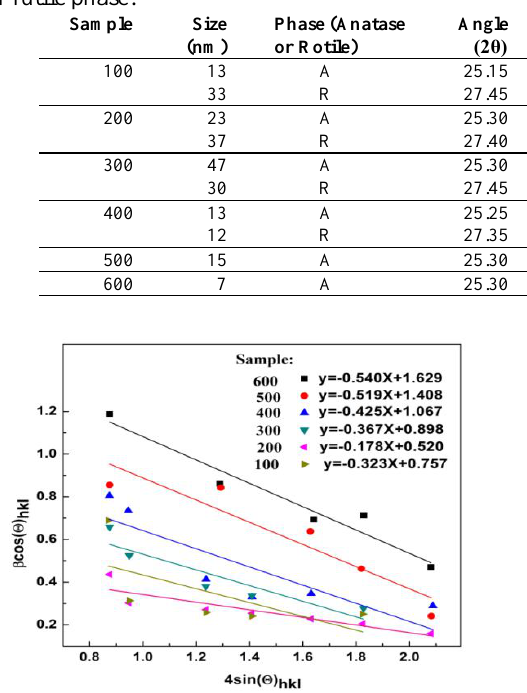
Fig. 4. Relation between βcosθ and 4sinθ (Williamson - Hall plots) with different TiO2 content in